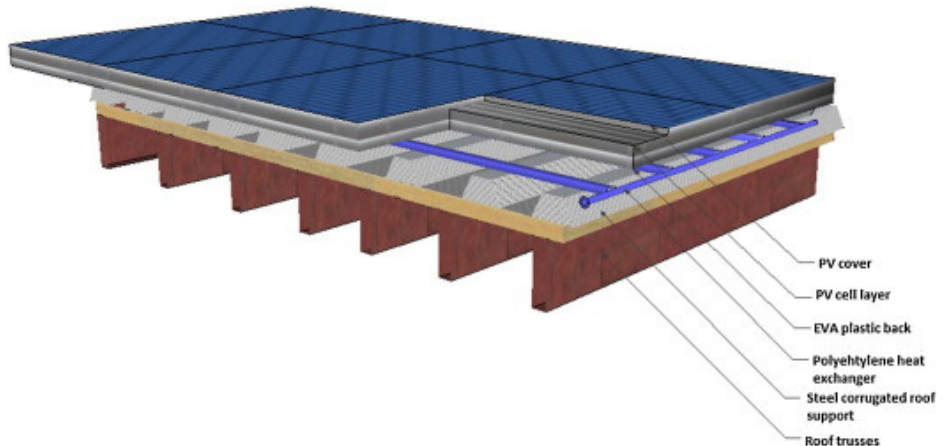
Figure 11. The integration of polyethylene heat exchanger underneath PV panels. Reproduced with permission from ref. [168]. Copyright 2014 Elsevier.